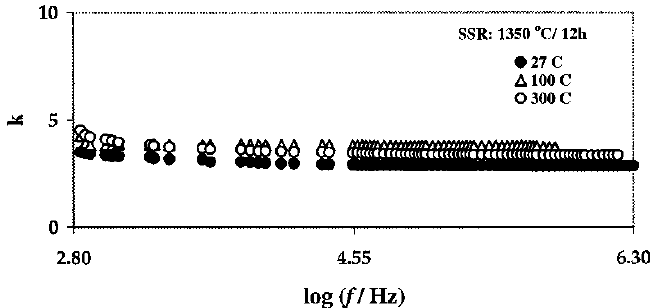
3 samples sintered at 1350